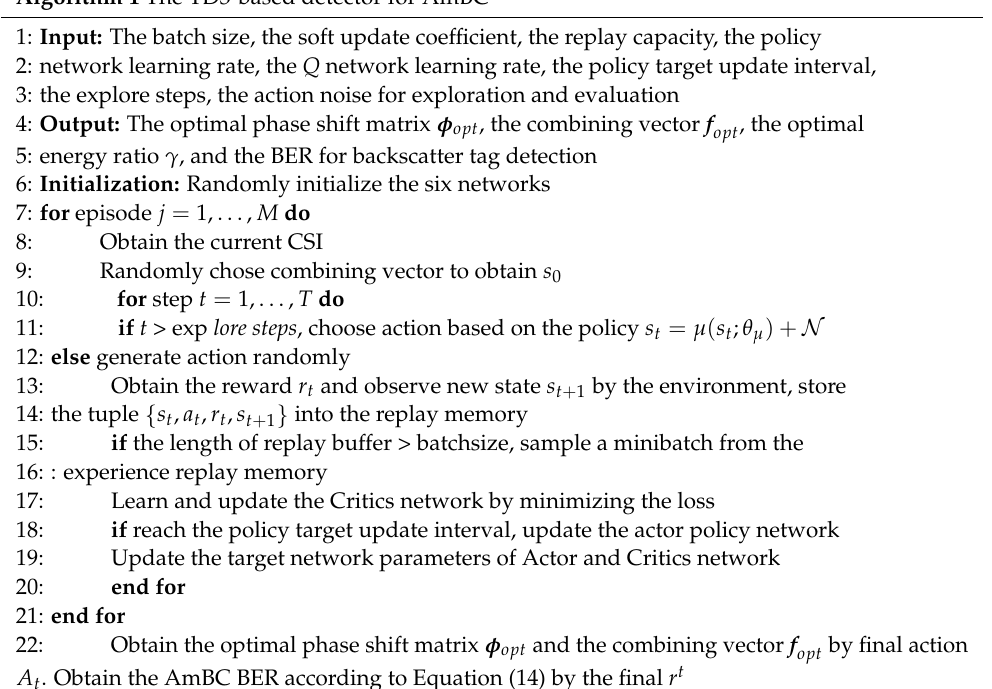
Algorithm 1 The TD3-based detector for